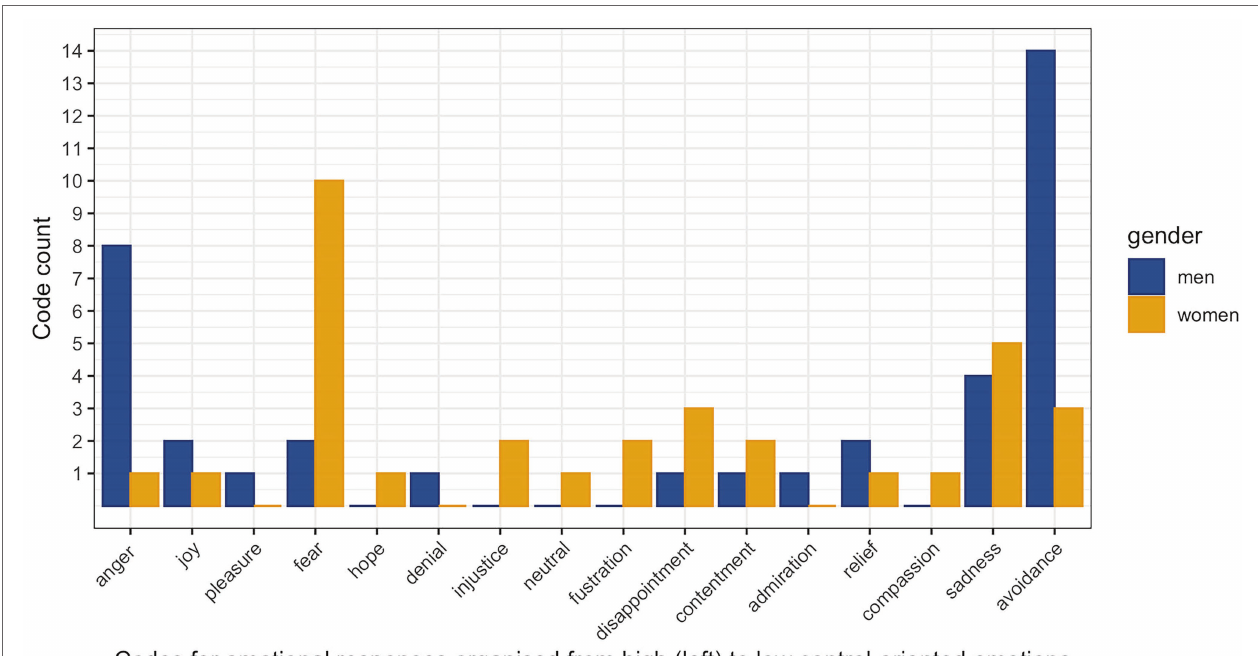
FIGURE 2 | Count for each emotion code by